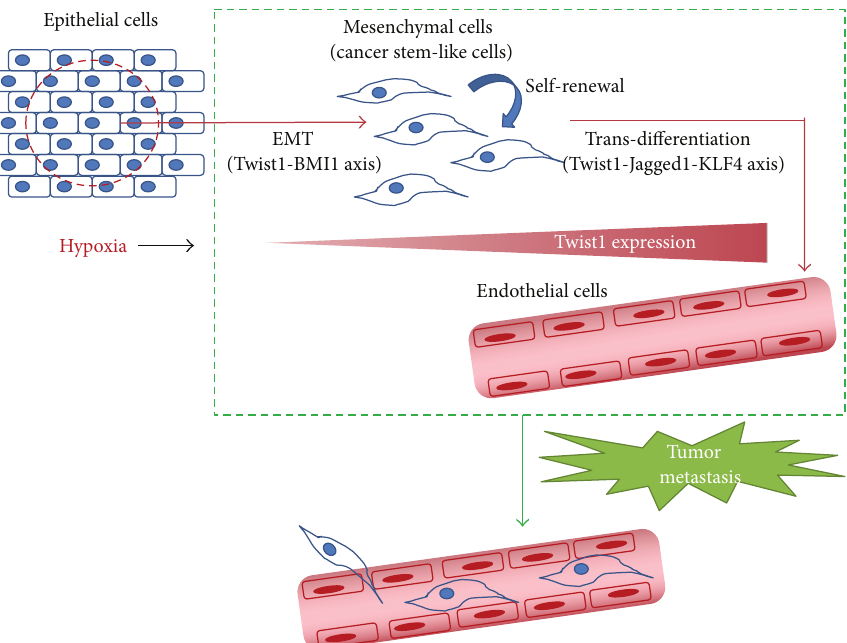
Figure 2: A model explains the crucial role of hypoxia-induced Twist1 to mediate different important processes of tumor progression including EMT, metastasis, cancer stemness, and endothelial differentiation through regulation of BMI1 or Jagged1/Notch-KLF4